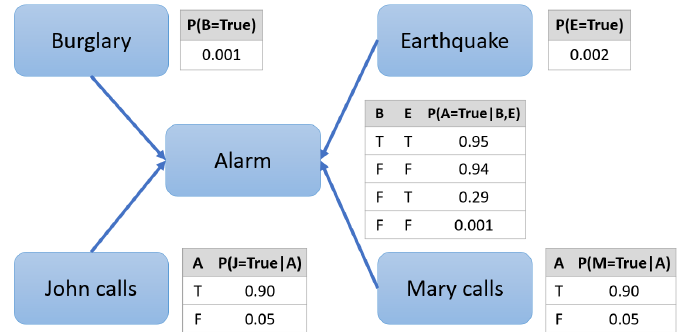
Figure 22. Toy example of a Bayesian network. A certain individual has an alarm installed at home, which fires in the case of minor earthquakes or burglaries (with a certain probability). The given individual also has two neighbors, Mary and John, who will call him in case they hear the alarm. Image adapted from [81].